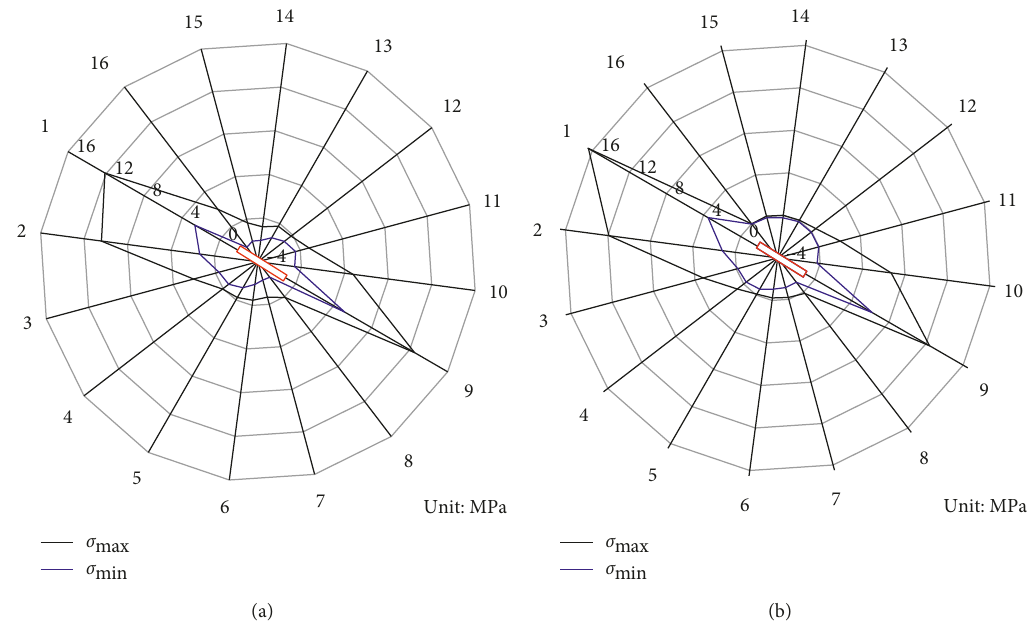
Figure 21: Principal stresses around middle joint for A30 at (a) crack initiation stress and (b) peak shear